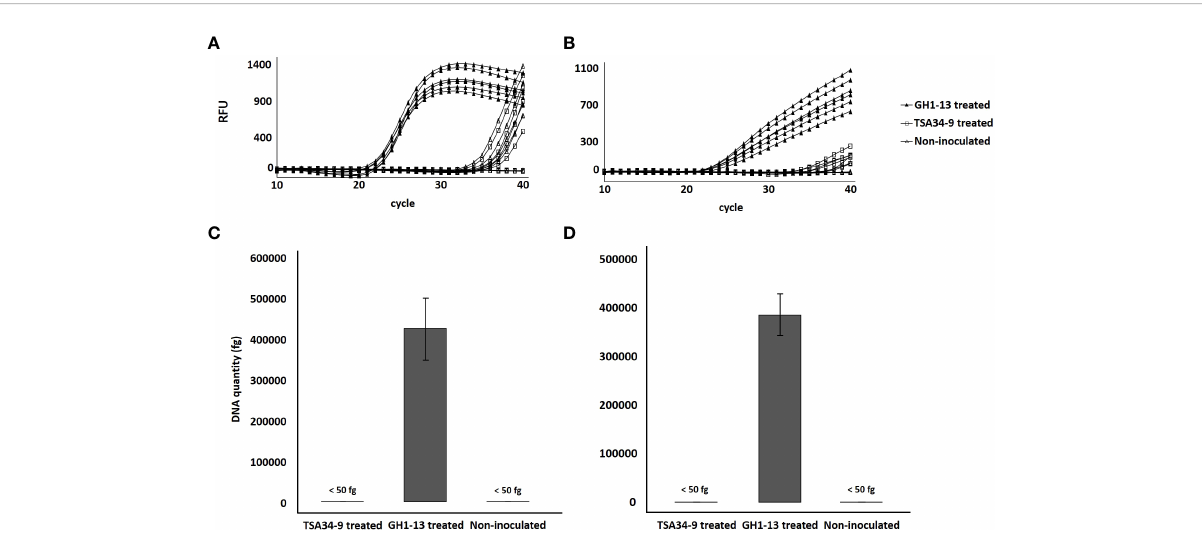
FIGURE 7 Ampli fi cation ofchromosomal unique gene regionof Bacillus velezensis GH1-13 from DNA templates of B. velezensis GH1-13treated, B. velezensis TSA34-9 treated, and non-inoculated soil samples (500 mg) by SYBR Green qPCR analysis using a primer pair F_uniqueC andR_uniqueC (A) and TaqMan qPCR analysis using a primer pair Ft_uniqueCand Rt_uniqueC (B) . DNA quantity of chromosomal unique gene regionof B. velezensis GH1-13 detected from B.velezensis GH1-13 treated, B. velezensis TSA34-9treated and non-inoculated soil samples (500 mg) by SYBR Green qPCR analysis usinga primer pair F_uniqueC and R_uniqueC (C) and TaqMan qPCRanalysisusinga primer pair Ft_uniqueCand Rt_uniqueC (D) .